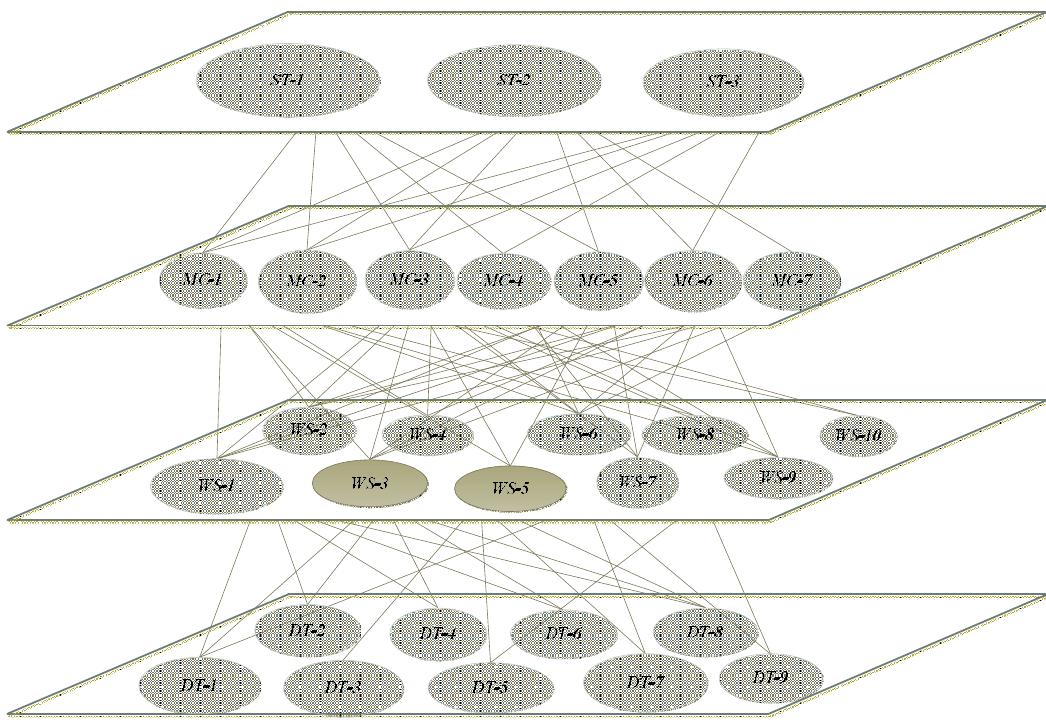
Figure 2. Requirement mapping model of defense technologies in the area of maritime security.